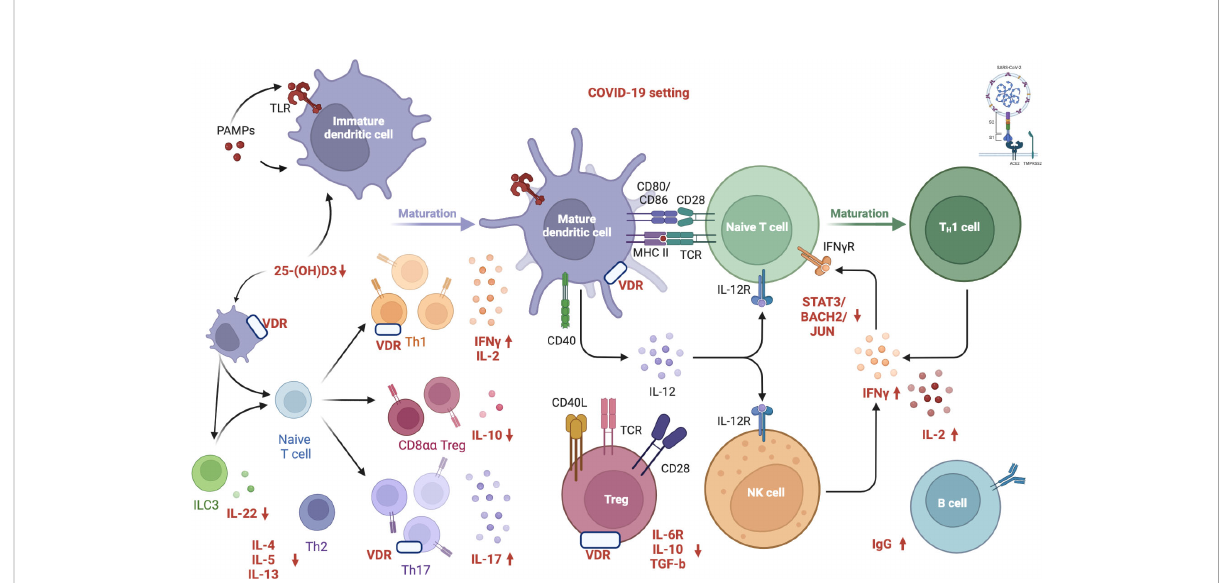
FIGURE 1 Proposed mechanism linking vitamin D de fi ciency to COVID-19 antibody response. “ Created with BioRender.com ” (Agreement number: MW24DBIWVD, Academic License). Vitamin D inhibits both the acquired immune system and stimulates the innate immune response as well. VDR modulates immunity processes, such as anti-microbial/anti-viral defense and the induction of T-cell tolerance. Several immune cells express the VDR and CYP27B1 (enzyme 1 a -hydroxylase that converts vitamin D to the active form, 1,25-dihydroxyvitamin D3). The activation of innate immunity in SARS-CoV-2 infection seems to result in an increased local 1,25(OH)2D3 production and viral clearance while altering the pro-in fl ammatory response. The active form of vitamin D, 1,25(OH)2D3, is an inhibitor of dendritic cell maturation and functions as an immune modulator, reducing the activation of the acquired immune system. Furthermore, vitamin D induces transcription factors, including STAT3, BACH2, and JUN, which repress TH1 and TH17 responses and increase IL-10 via IL-6-STAT3 signaling, which is crucial in resolving type 1 in fl ammation in severe COVID-19 patients. Low vitamin D levels impair innate immune function, inactivating T reg cells and expanding the activated T and B cells, along with the immunoglobulin production. Speci fi cally, human CD4+ T cell activation is associated with high levels of IFN g , IL-2, IL-17, and low levels of IL-6R, TGF- b , and IL-10, resulting in the pro-in fl ammatory TH1 skewing and potentially severe tissue damage. COVID-19: Coronavirus Disease 2019; SARS CoV 2: Severe Acute Respiratory Syndrome Coronavirus 2; S1: S1 domain of the coronavirus spike (S) protein; TMPRSS2: Transmembrane protease serine 2; S2: S2 domain of the coronavirus spike (S) protein; ACE2: Angiotensin-Converting Enzyme 2; PAMP: Pathogen Associated Molecular Patterns; TLR: Toll-like receptor; 25(OH)D3: 25-hydroxycholecalciferol; ILC3: Type 3 Innate Lymphoid Cells; IL-22: Interleukin 22; IL-4: Interleukin 4; IL-5: Interleukin 5; IL-13: Interleukin 13; Th2: Type 2 T Helper Cell; Th1: Type 1 T Helper Cell; Th17: Type 17 T Helper Cell; VDR: Vitamin D Receptor; CD8 aa : Cluster of Differentiation 8 aa ; Treg: Regulatory T cells; IFN g : Gamma Interferon; IL-2: Interleukin 2; IL-10: Interleukin 10; IL-17: Interleukin 17; CD40: Cluster of Differentiation 40; CD80: Cluster of Differentiation 80; CD86: Cluster of Differentiation 86; CD28: Cluster of Differentiation 28; MHCII: Major Histocompatibility Complex; TCR: Toll- like receptor; IL-12: Interleukin 12; IL-12R: Interleukin-12 Receptor; CD40L: Cluster of Differentiation 40 Ligand; CD28: Cluster of Differentiation 28; IL-6R: Interleukin-6 Receptor; TGF- b : Transforming Growth Factor Beta; NK: Natural Killer; IFN g R: Gamma Interferon Receptor; STAT3: Signal Transducer And Activator Of Transcription 3; BACH2: BTB Domain And CNC Homolog 2; JUN: Jun proto-oncogene; IgG: Immunoglobulin G. APC: Antigen-presenting cells; VDR: vitamin D